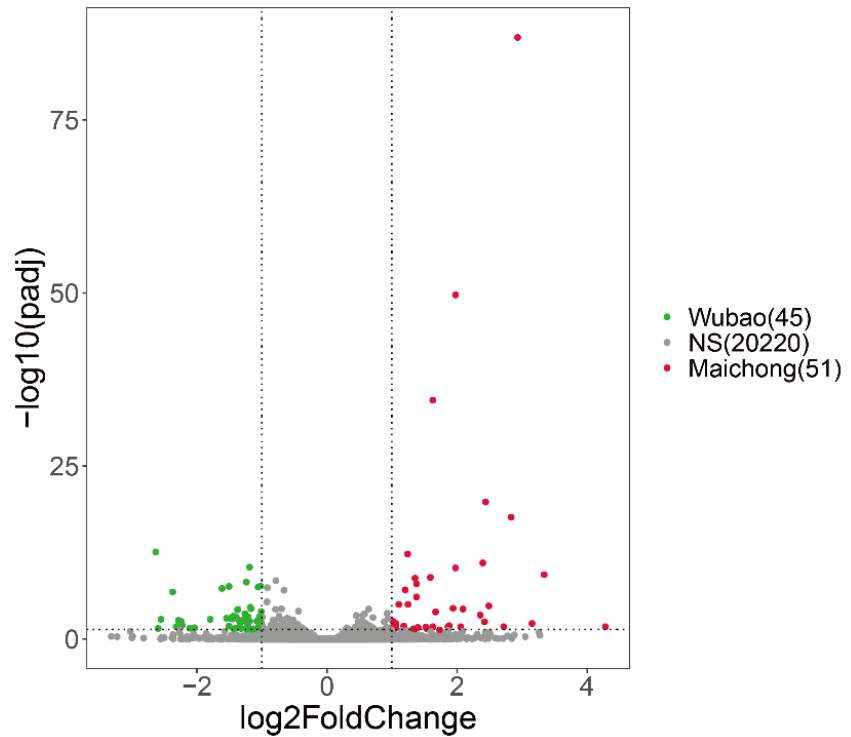
Figure A4. Volcano plot of DEGs in the comparisons of Wubao and Maichong. Green dots represent genes up-regulated in Wubao. Red dots represent genes up-regulated in Maichong. Grey dots represent genes that show no significant difference between two orchards.